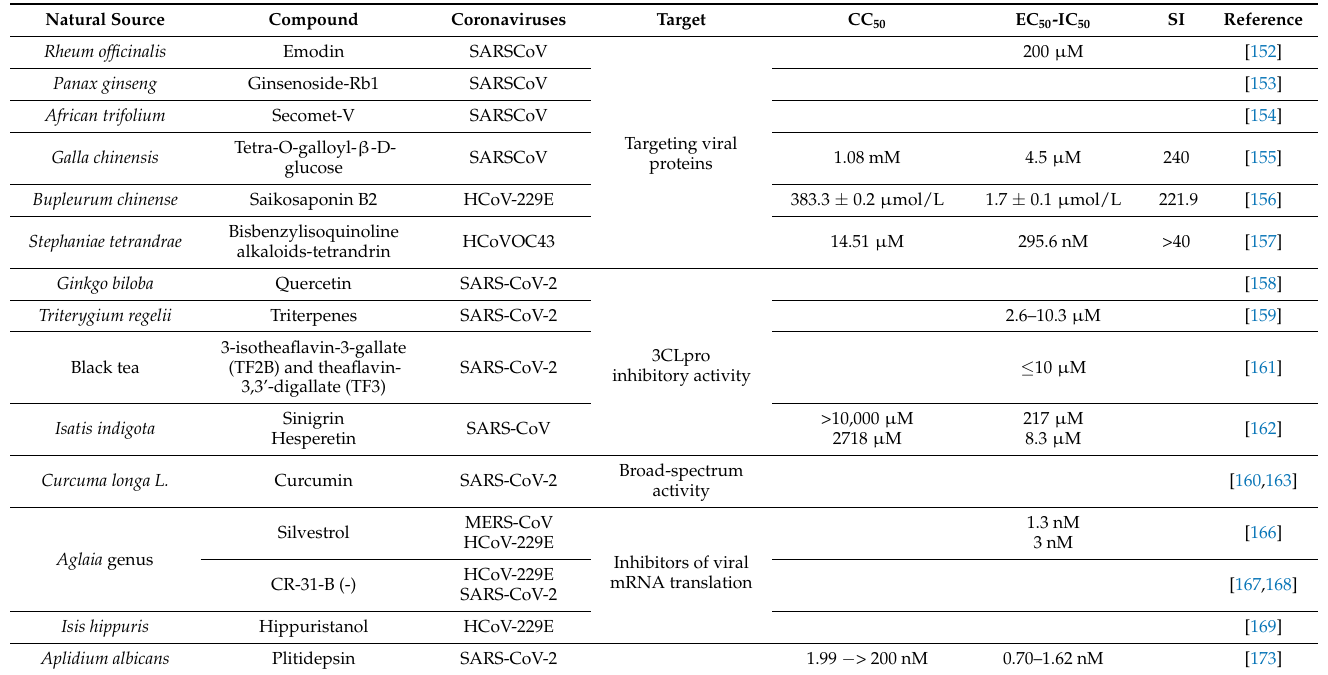
Table 10. Natural compounds and their antiviral targets against